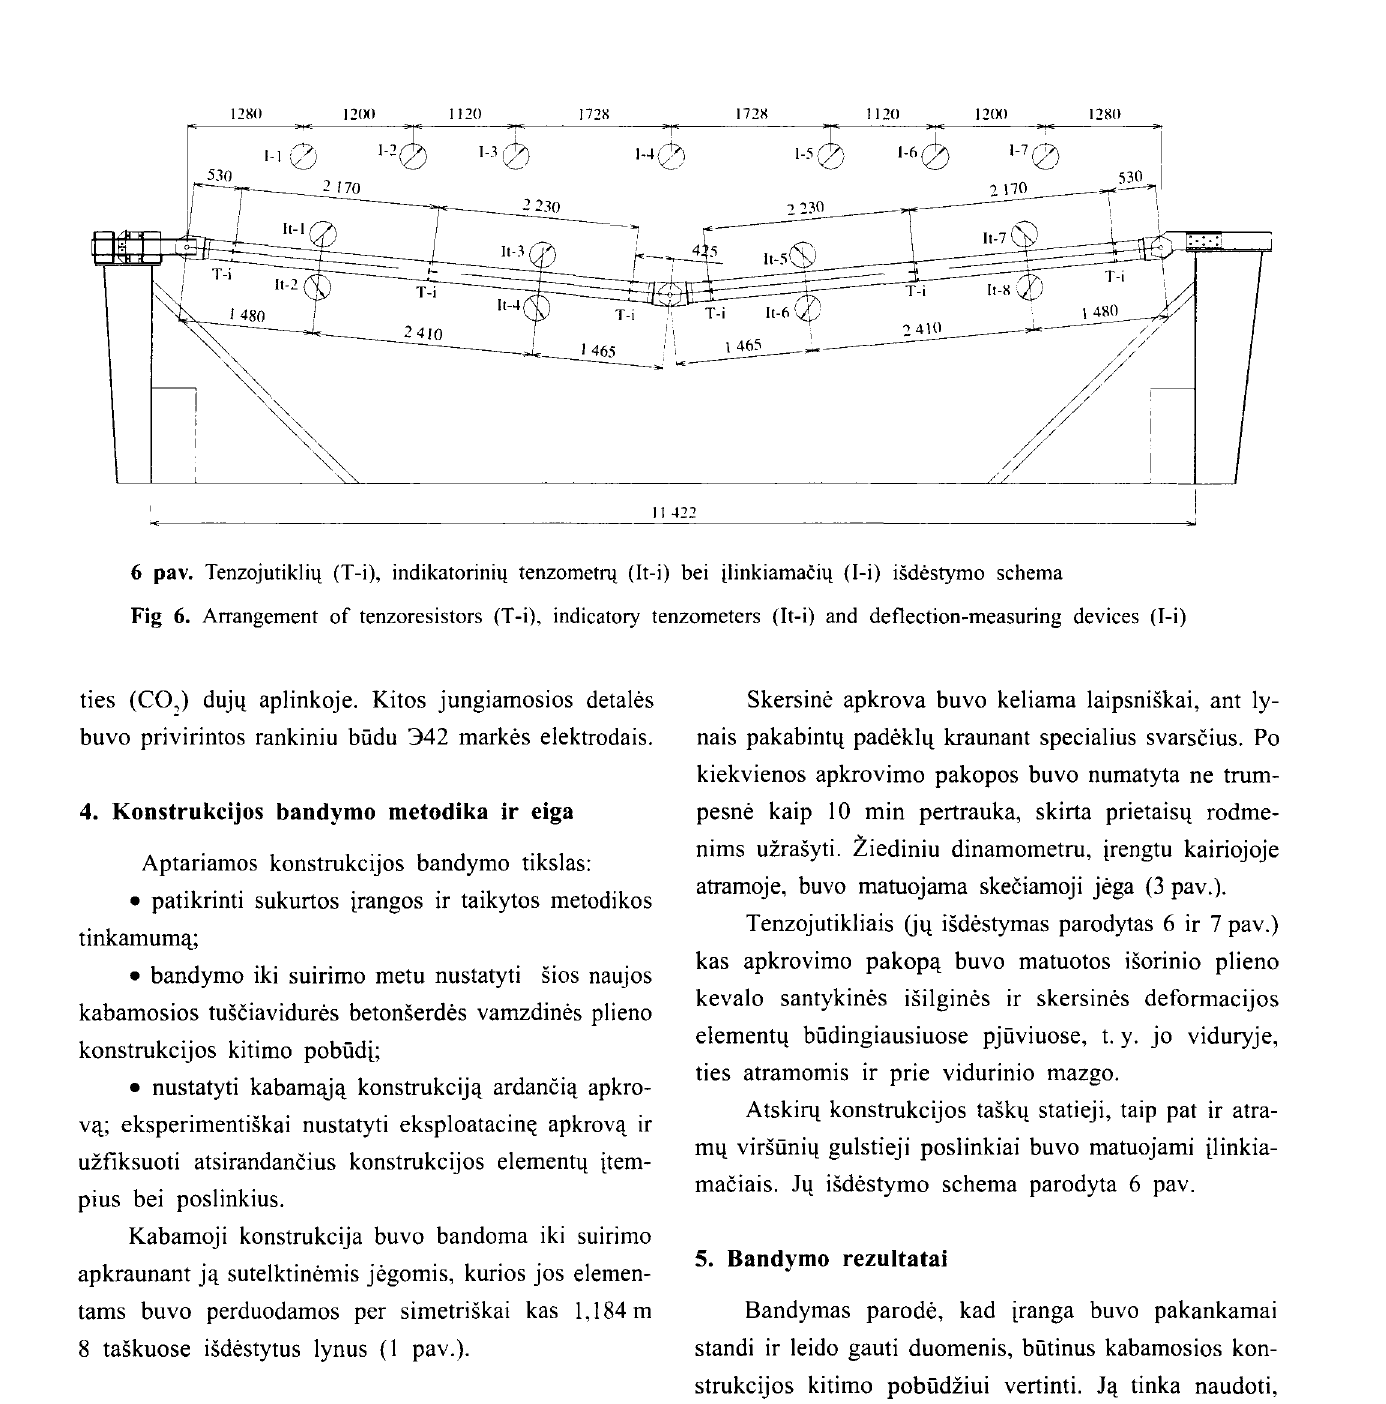
Fig 6. Arrangement of tenzoresistors (T-i). indicatory tenzometers (lt-i) and deflection-measuring devices (1-i)